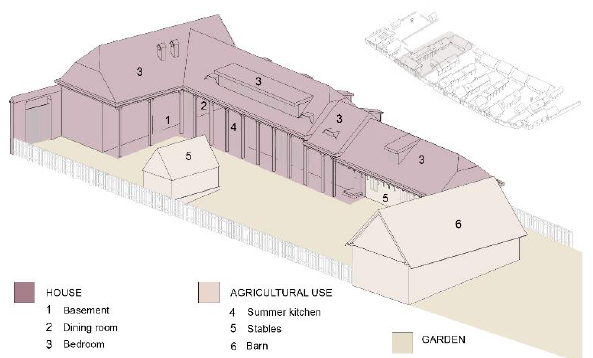
Figure 11. Graphical reconstruction of a typical dwelling in the village of Viscri.